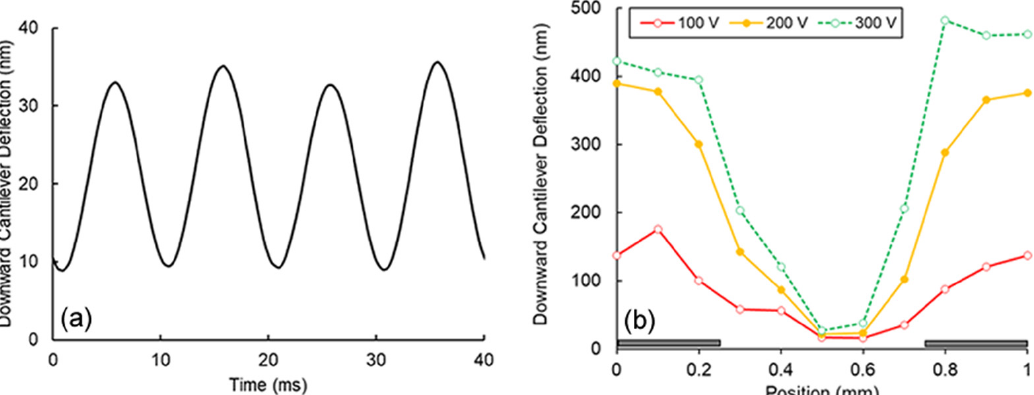
Figure 3. ( a ) A portion of the time trial demonstrating oscillatory deflection of an AFM for a 50 Hz field. ( b ) AFM deflection as a function of voltage and position. Electrodes are illustrated as dark rectangles.